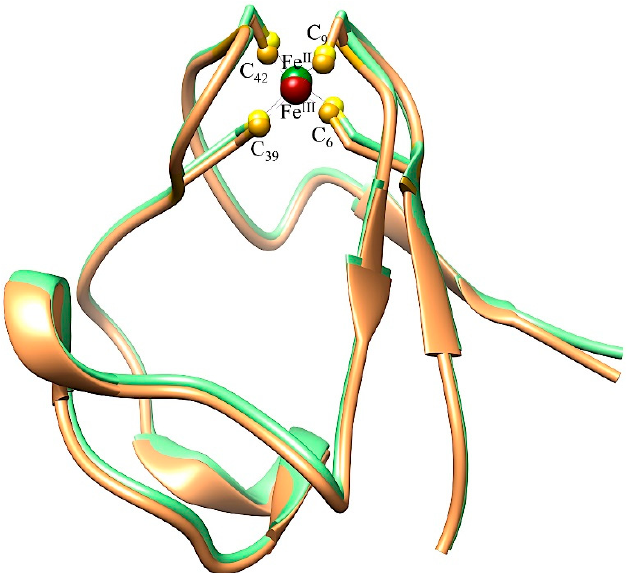
Figure 1. Superimposed of X-ray structures of native Rds from Clostridium pasteurianum ; oxidized Fe III -Rd (light brown ribbon with red Fe III ball) (PDB: 1FHH) and reduced Fe II -Rd states (light green ribbon with green Fe II ball) (PDB: 1FHM).